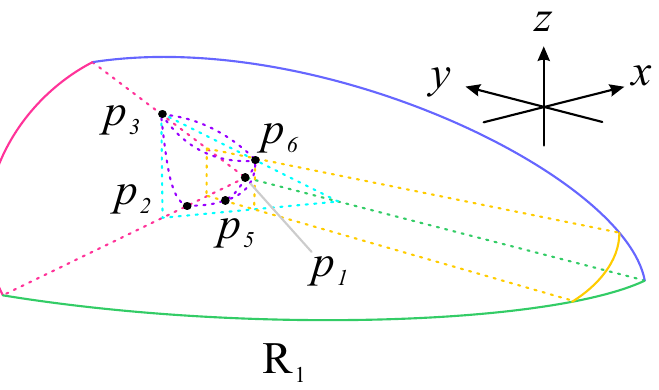
Figure 2. The purple surface is b 1 = 0, the yellow plane is b 2 = 0, and the light blue plane is b 3 = 0.